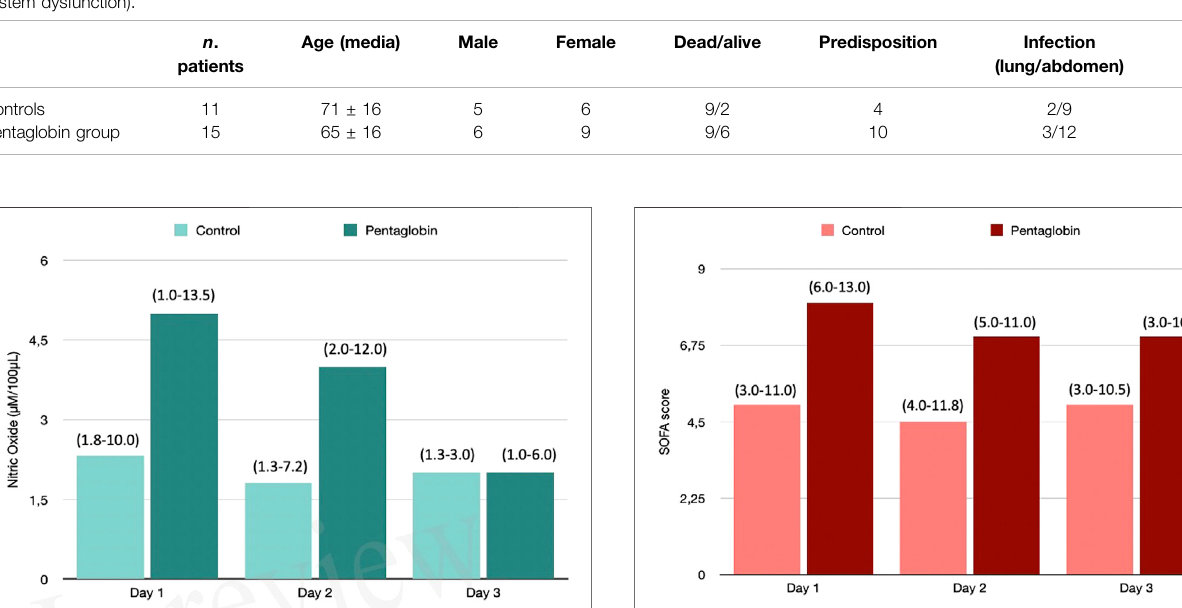
SOFA score at admission was 18.6 ± 4.5 in Pentaglobin treated